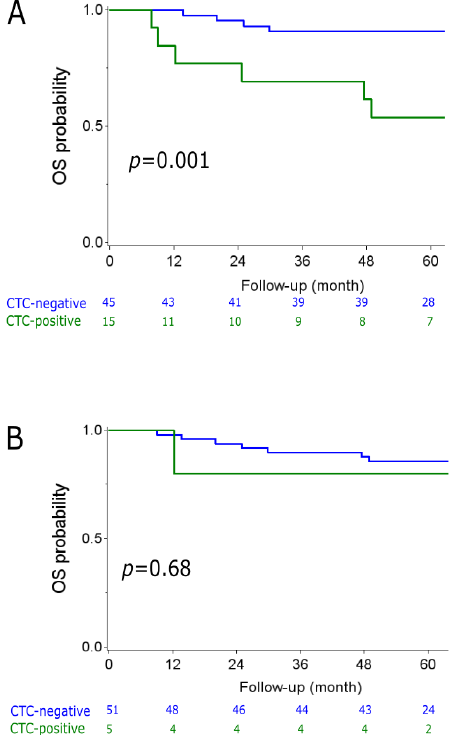
Figure 1. Kaplan–Meier curves for overall survival (OS) depending on the CTC status (green = CTC-positive; blue = CTC-negative). ( A ): CTC status at baseline. ( B ) CTC status after one cycle of treatment. p = Log-rank p -value.